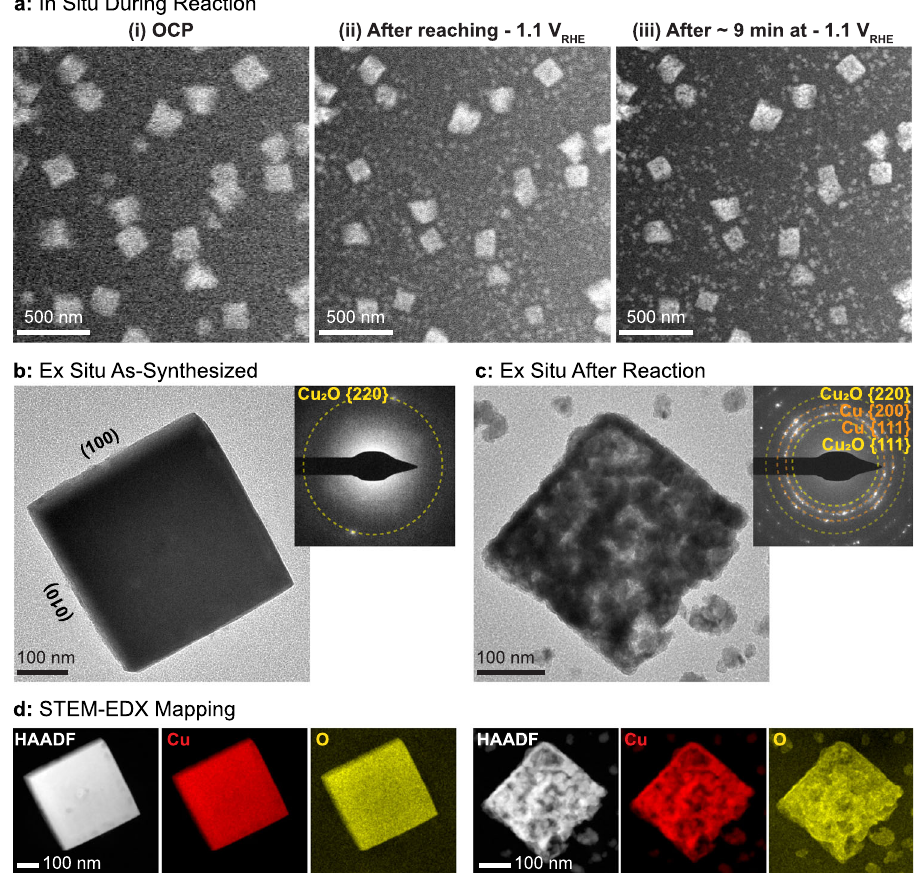
Fig. 1 Morphology of Cu 2 O cubes and their evolution during CO 2 RR. a Sequence of images illustrating the morphological changes observed in ~170 nm cubes after (i) introducing CO 2 saturated 0.1 M KHCO 3 under open circuit potential, (ii) while applying a reductive potential of − 1.1 V RHE and (iii) after ~9 min at − 1.1 V RHE , where a large bubble formed. The image sequences were all acquired with an electron fl ux of 1.7 e − Å − 2 s − 1 . Comparison of Cu 2 O cubes b before and c after reaction using ex situ TEM imaging and electron diffraction (upper right inserts). d STEM-EDX maps of the same cubes showing the Cu and O